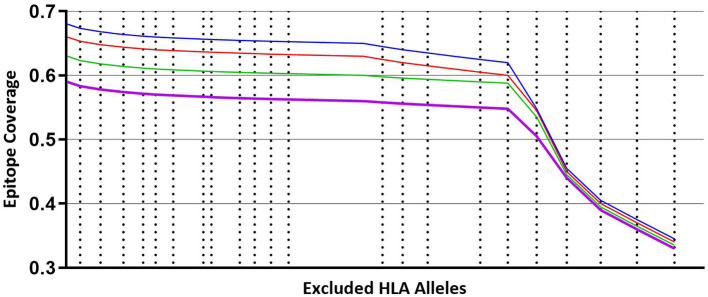
Coverage per predicted peptide calculated against a defined set of HLA alleles. Size of segments on X axis from left to right represents cumulative, combined HLA allele frequencies that are iteratively removed from the analysis, starting with least frequent alleles. Blue line—modeling using predicted 300 peptides. Red line—modeling using predicted 250 peptides. Green line—modeling using predicted 200 peptides. Purple line—modeling using predicted 150 peptides.